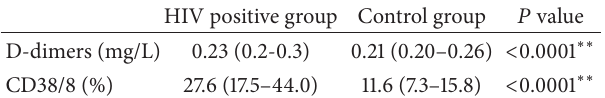
Table 5: Other markers of disease in HIV infection in both the HIV positive and control